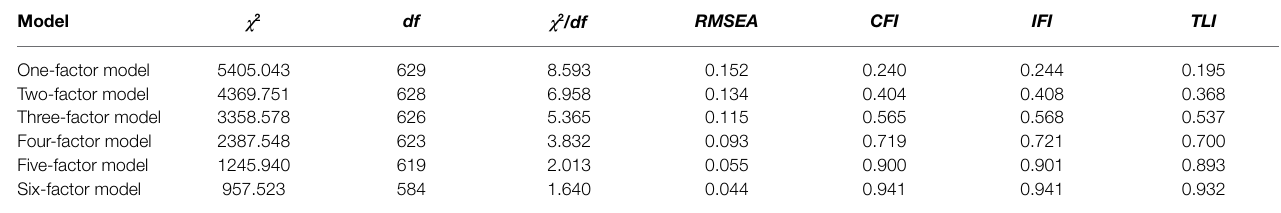
TABLE 1 | Results of confirmatory factor analyses. Model One-factor